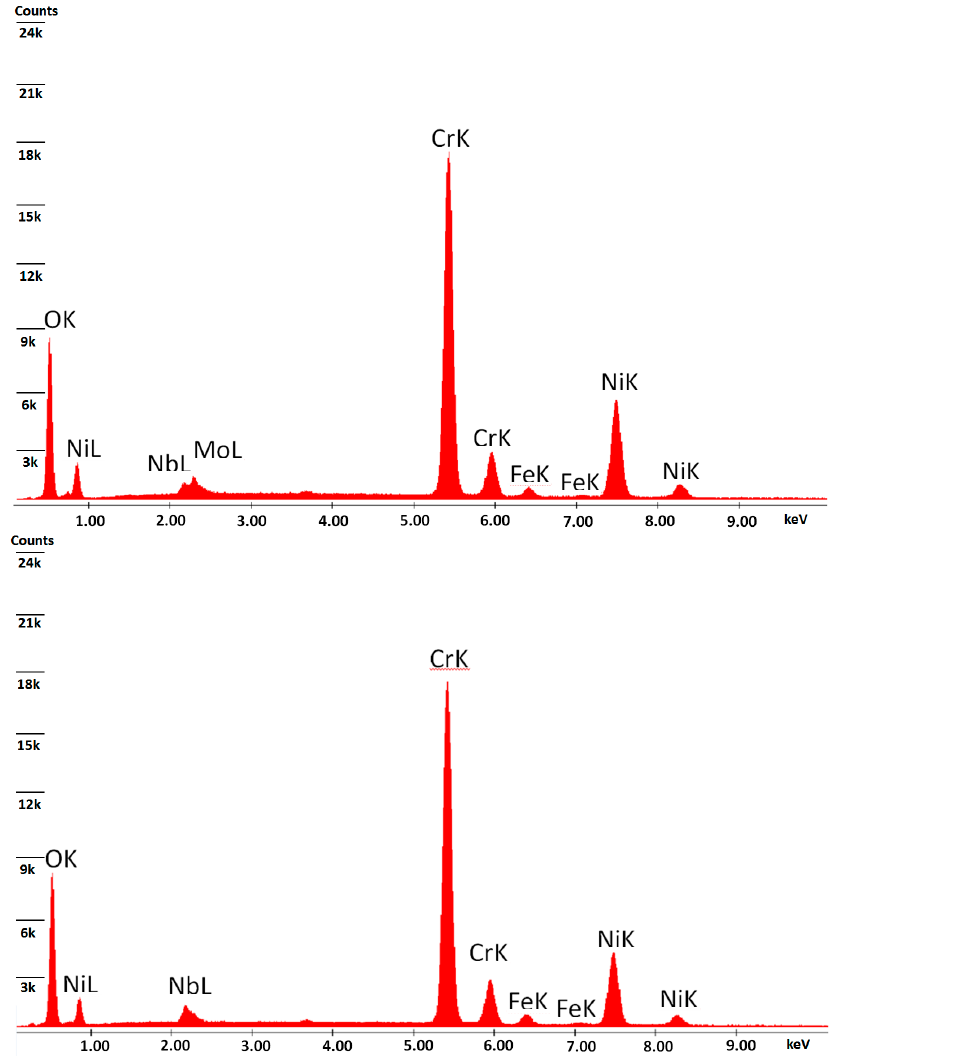
◦ C ( a ) and 1050 ◦ C ( b